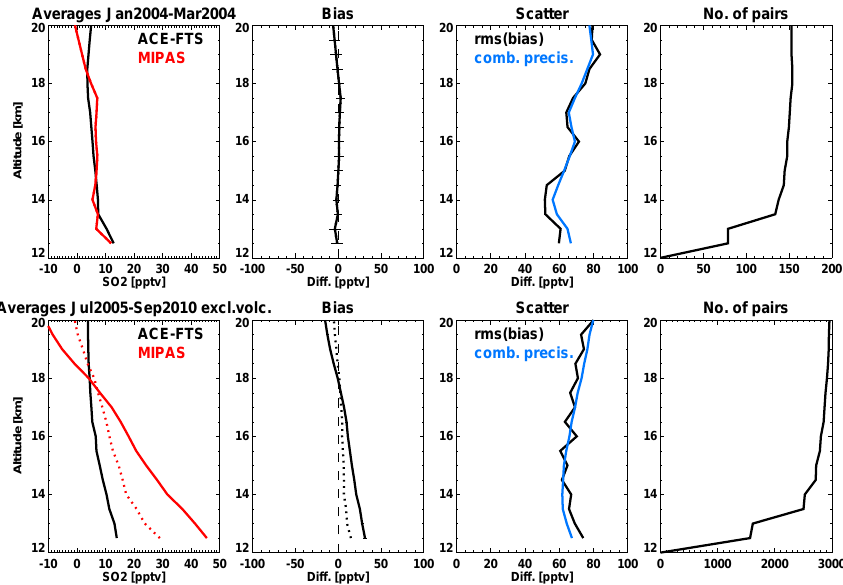
Figure 3. Same as top row in Fig. 2 but (1) separated in MIPAS phase 1 (top row) and phase 2 (bottom row) observation periods